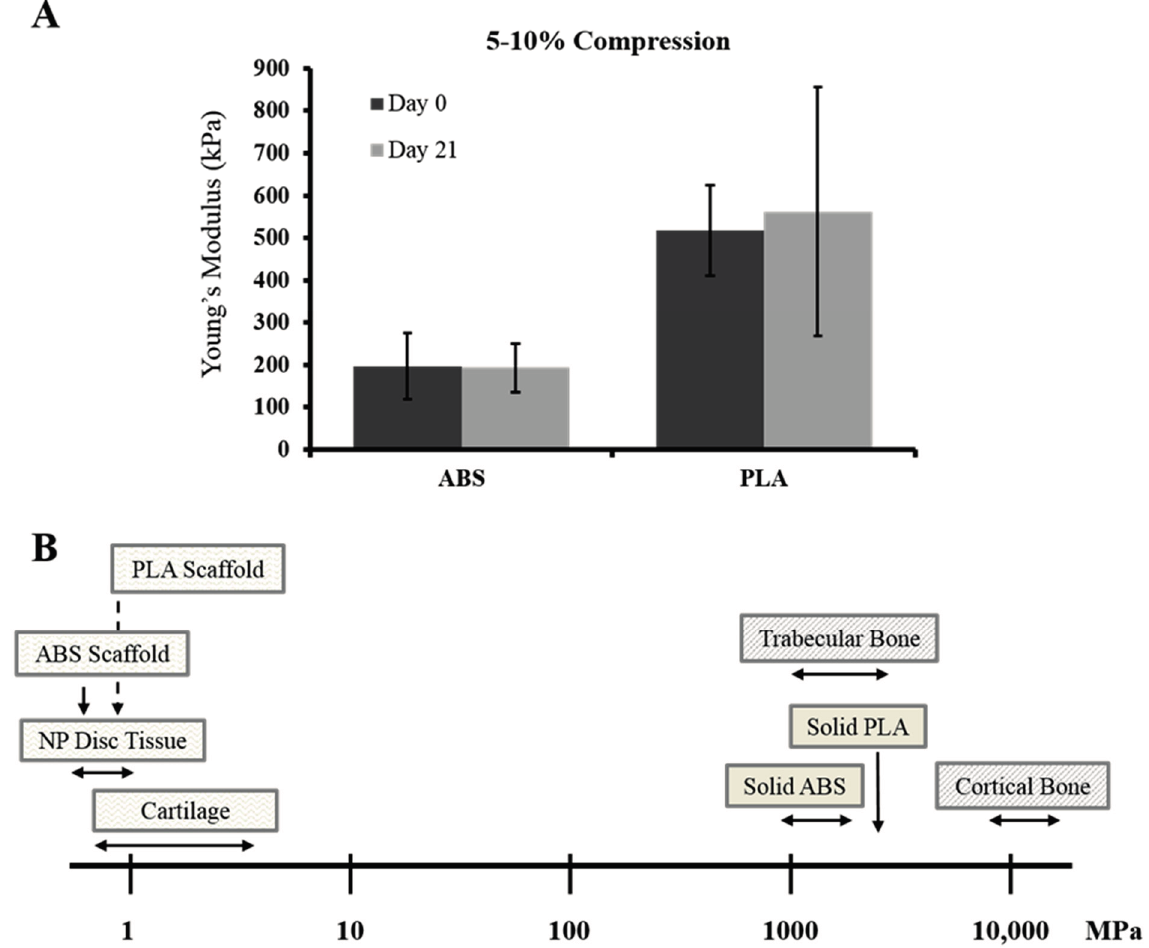
Figure 2. Mechanical testing of ABS and PLA scaffolds. ( A ) Young’s modulus was calculated between 5%–10% compressive strain/strain curves for freshly printed (day 0) and culture medium bathed (day 21) ABS and PLA scaffolds. For each set, n = 5. Error bars represent ± SD; ( B ) Cartoon representation of mechanical test data for printed scaffolds placed in context of known mechanical bulk properties of ABS and PLA plastics, as well as human NP tissue, articular cartilage, and bone. Horizontal arrows indicate a range of stiffness, while downward arrows indicate exact